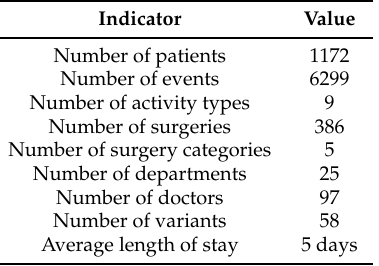
Table 6. Summary of event logs (as retrieved by